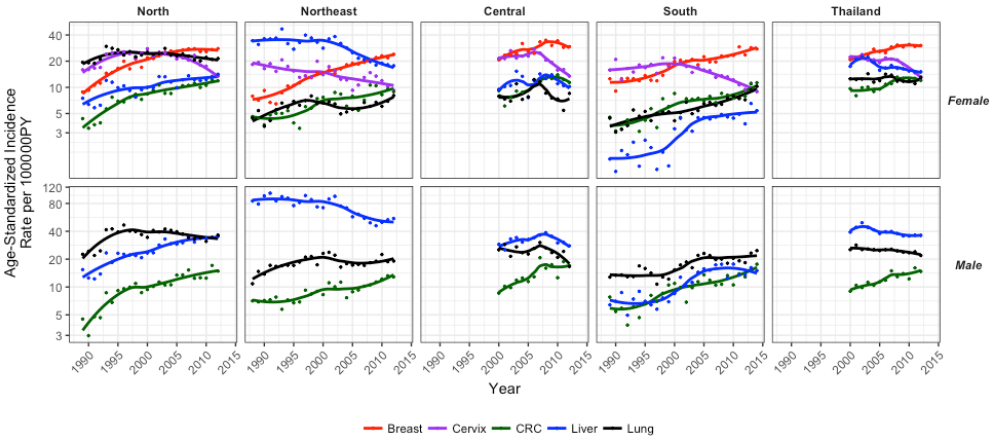
Figure 4. National and subnational estimates for incidence of the top five cancers combined for females and males.